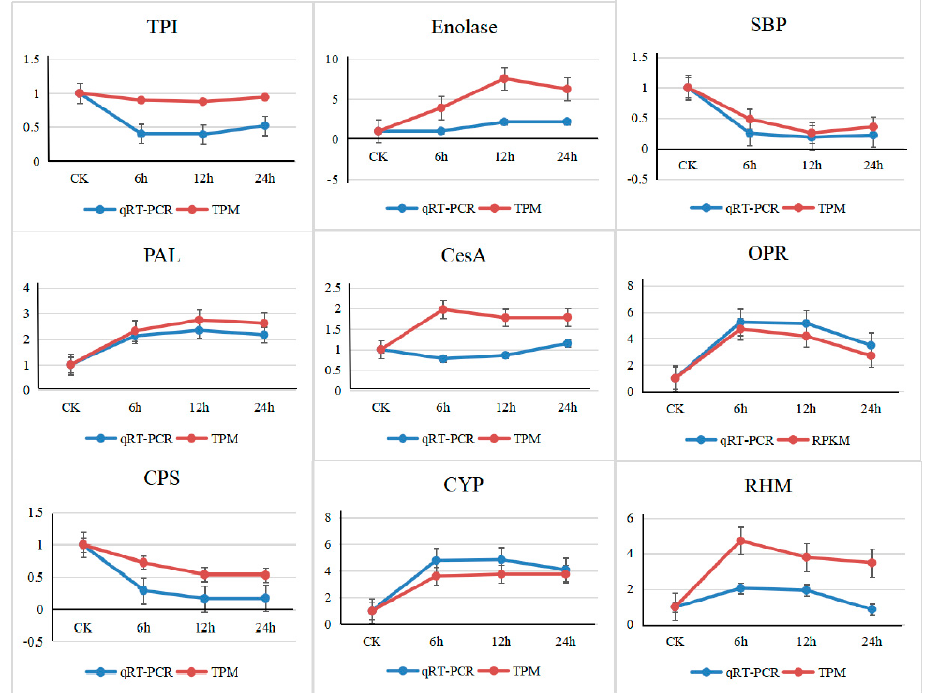
Figure 5. The expression changes in the 9 randomly selected genes were determined using quantitative real-time PCR (qRT-PCR) results and sequencing data. The x-axis represents different processing times, and the y-axis represents changes in gene expression under CO 2 stress. The data show the fold change in the expression of each gene under high CO 2 relative to control conditions. Error bars represent standard deviations. Red indicates the RNA-sequencing results under the TPM (transcripts per million reads) algorithm, and blue indicates the qRT-PCR results.